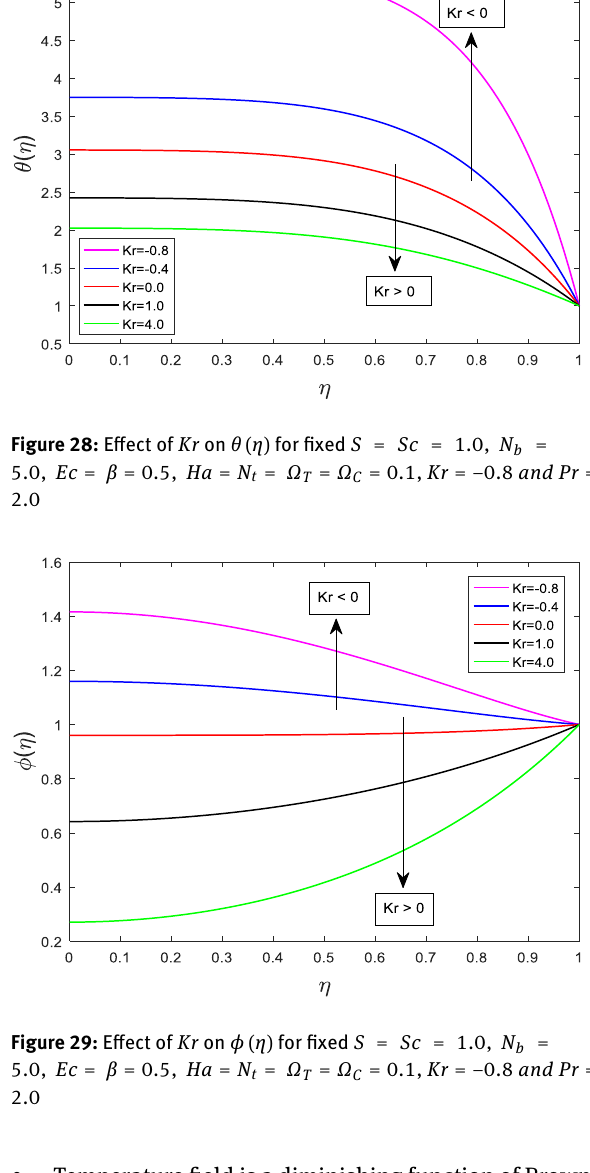
= Ω = Ω = 0.1, Kr = −0.8 and Pr = t T C